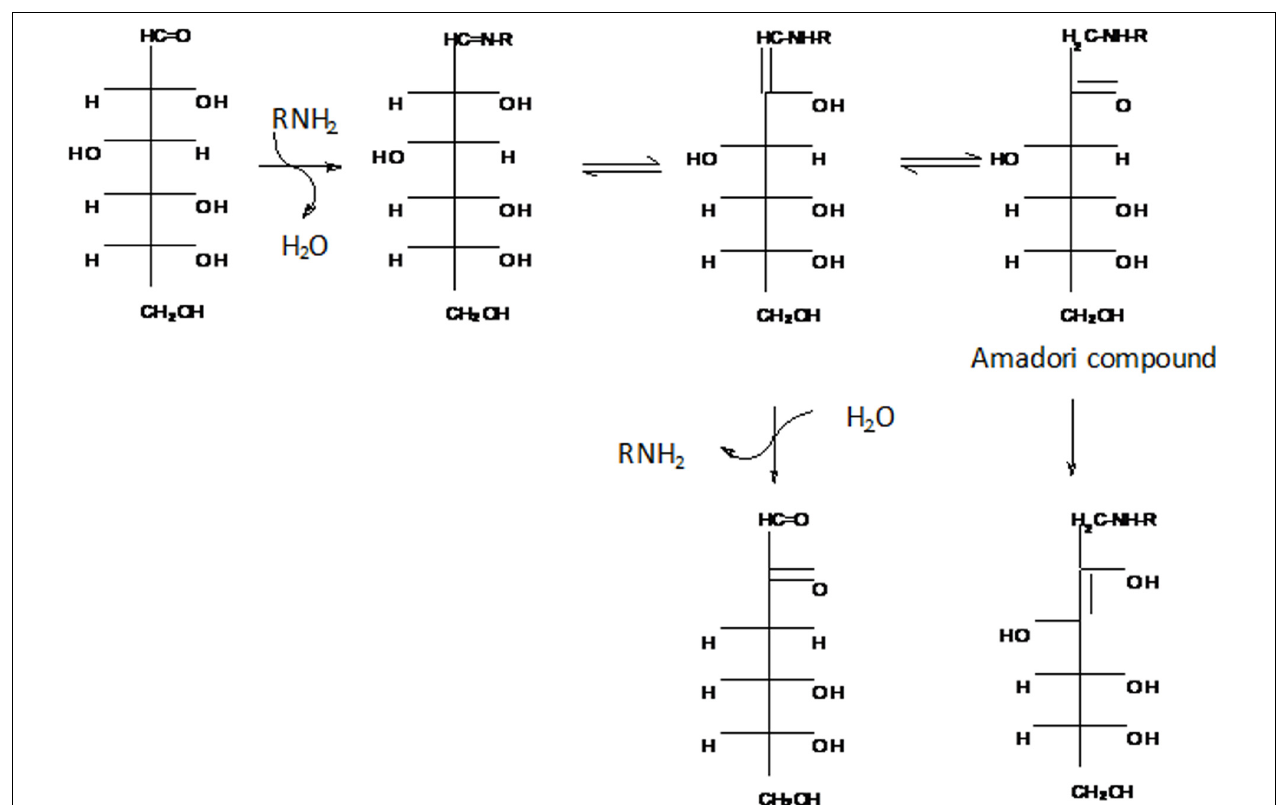
FIGURE 4 | Glucose and amino acid interaction (R, amino acid side group) [Badji, 2017; from Fennema (1996)].